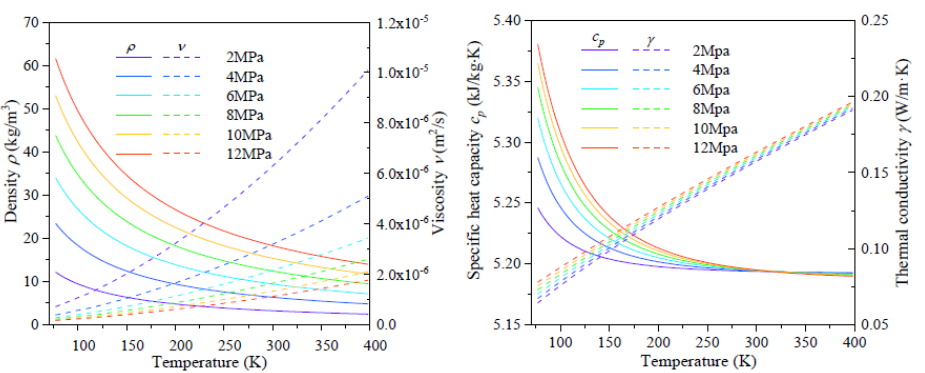
Figure 5. Variations of the supercritical helium thermophysical properties with pressure and temperature.